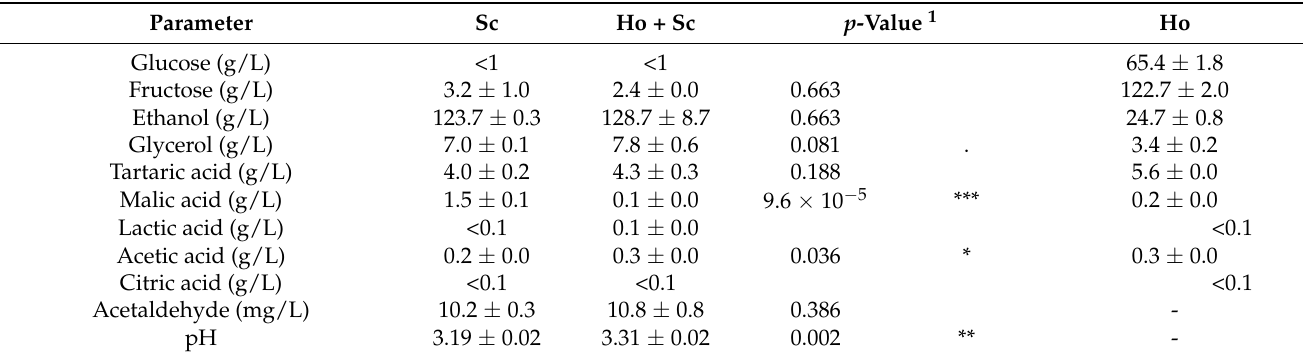
Table 1. Parameters of the wines after fermentation.